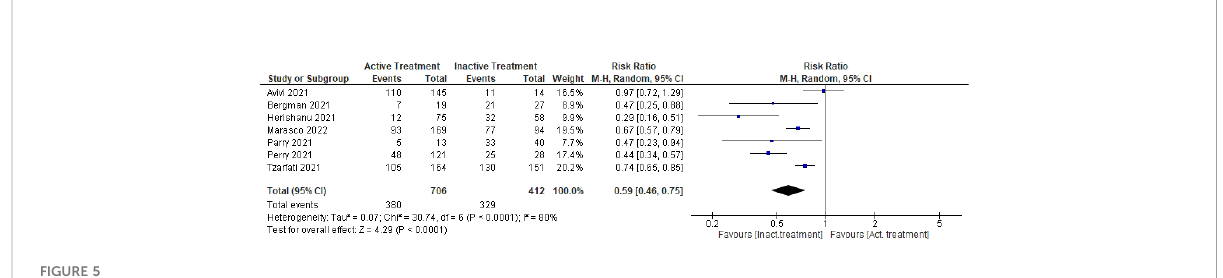
FIGURE 5 Sub-analysis of the seroconversion rate comparing active or inactive